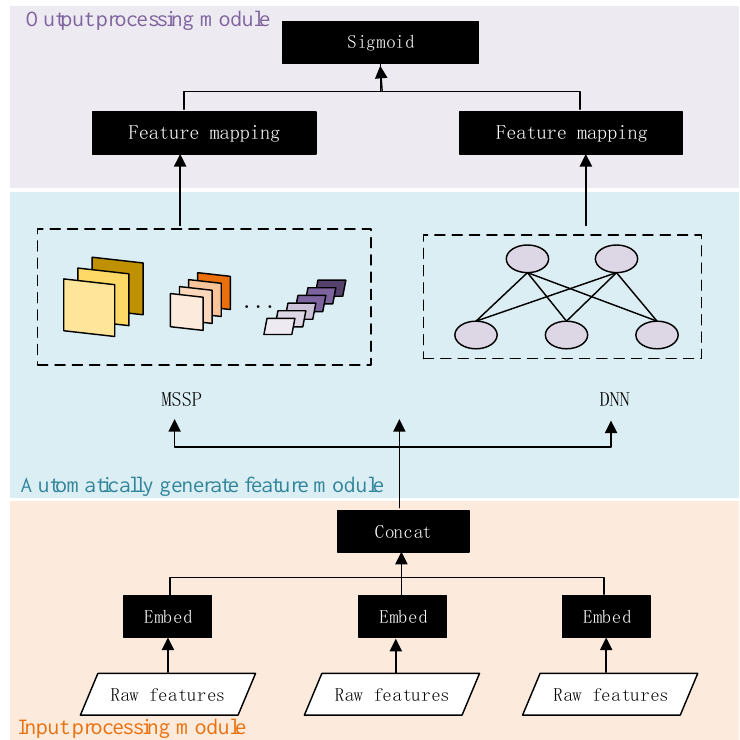
Figure 1. The whole structure of sDeepFM.